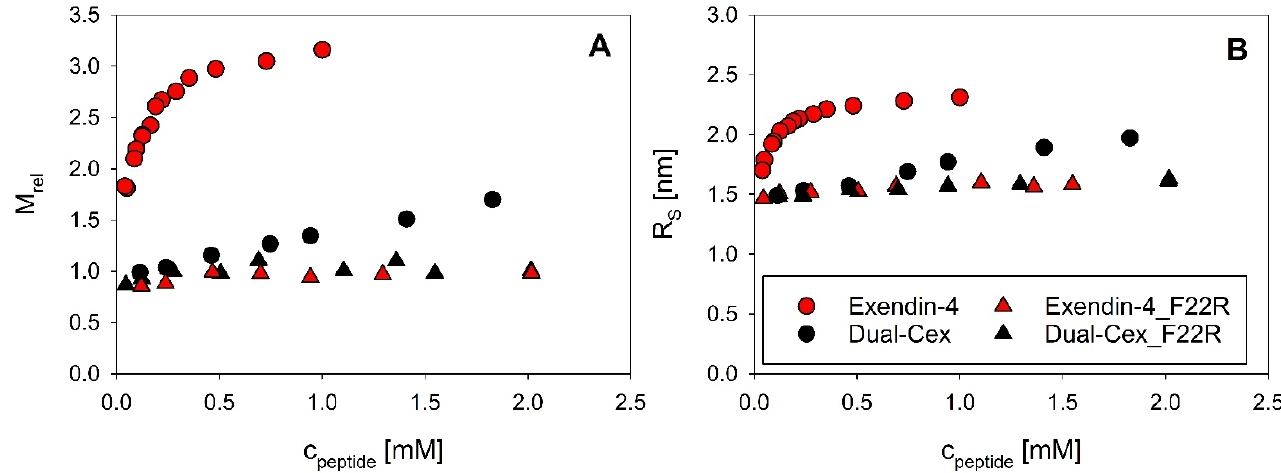
Figure 6. Association equilibria of exendin-4 and Dual-Cex and the F22R mutants of both peptides. Relative molecular